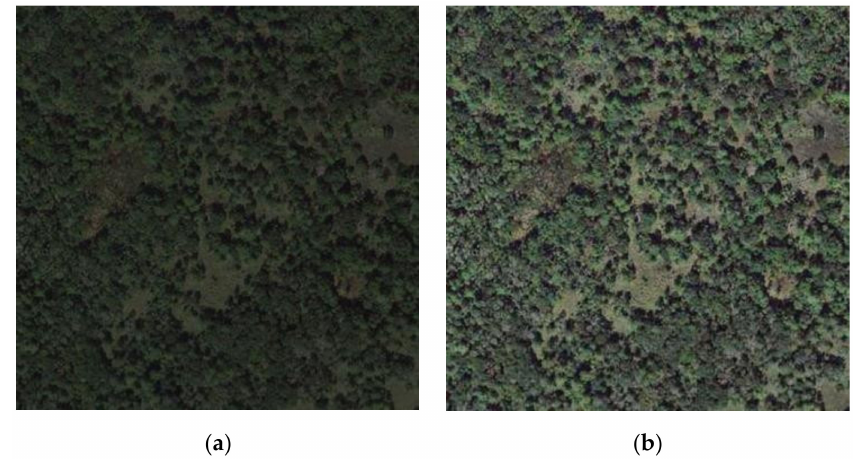
Figure 6. ( a ) Original image. ( b ) Improved image using